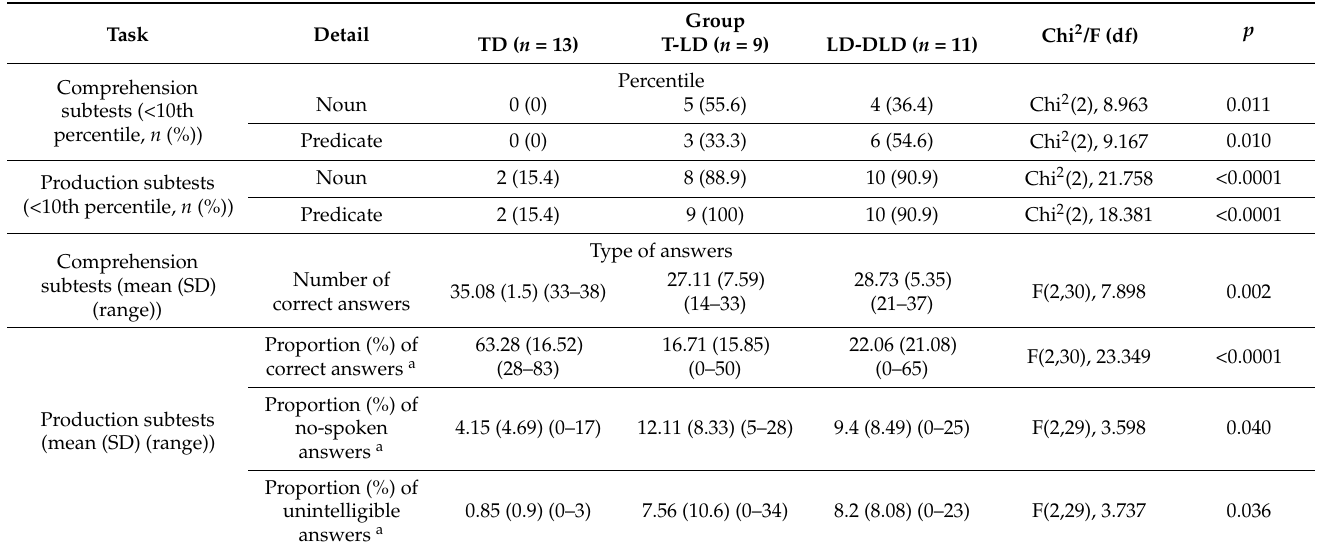
Table 3. Measures from the PiNG